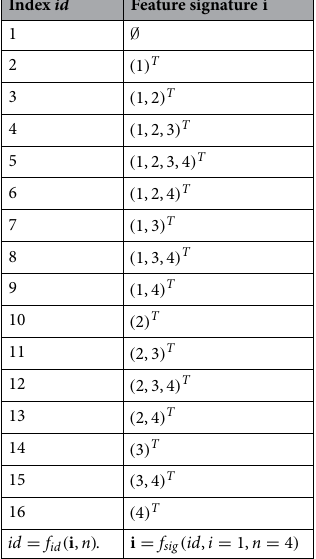
Table 1. Direct mapping of signature indices id and feature signatures i . The table lists an example for n = 4 features according to the proposed enumeration scheme. The id of a feature signature i can be calculated directly via the function call f id ( i , n ) . The feature signature of an id is given by i = f sig ( id , i = 1, n = 4 )